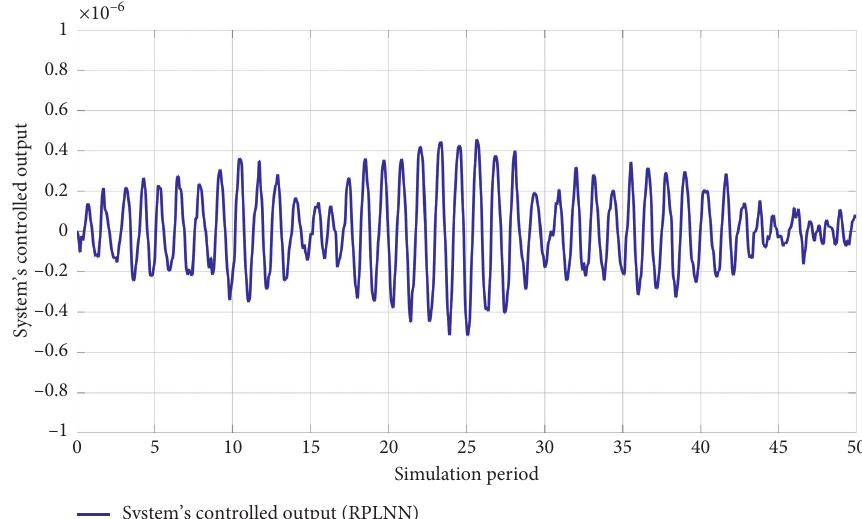
Figure 9: Noise cancellation utilizing the RPLNN controller.